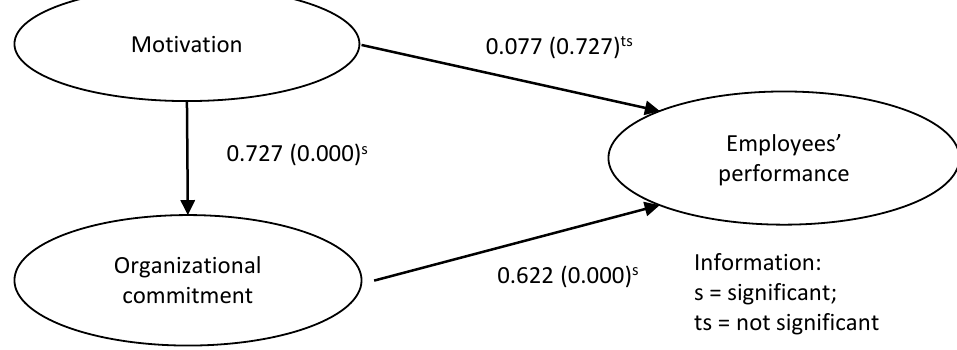
Figure 1. Diagram of test results for the hypothesis of direct